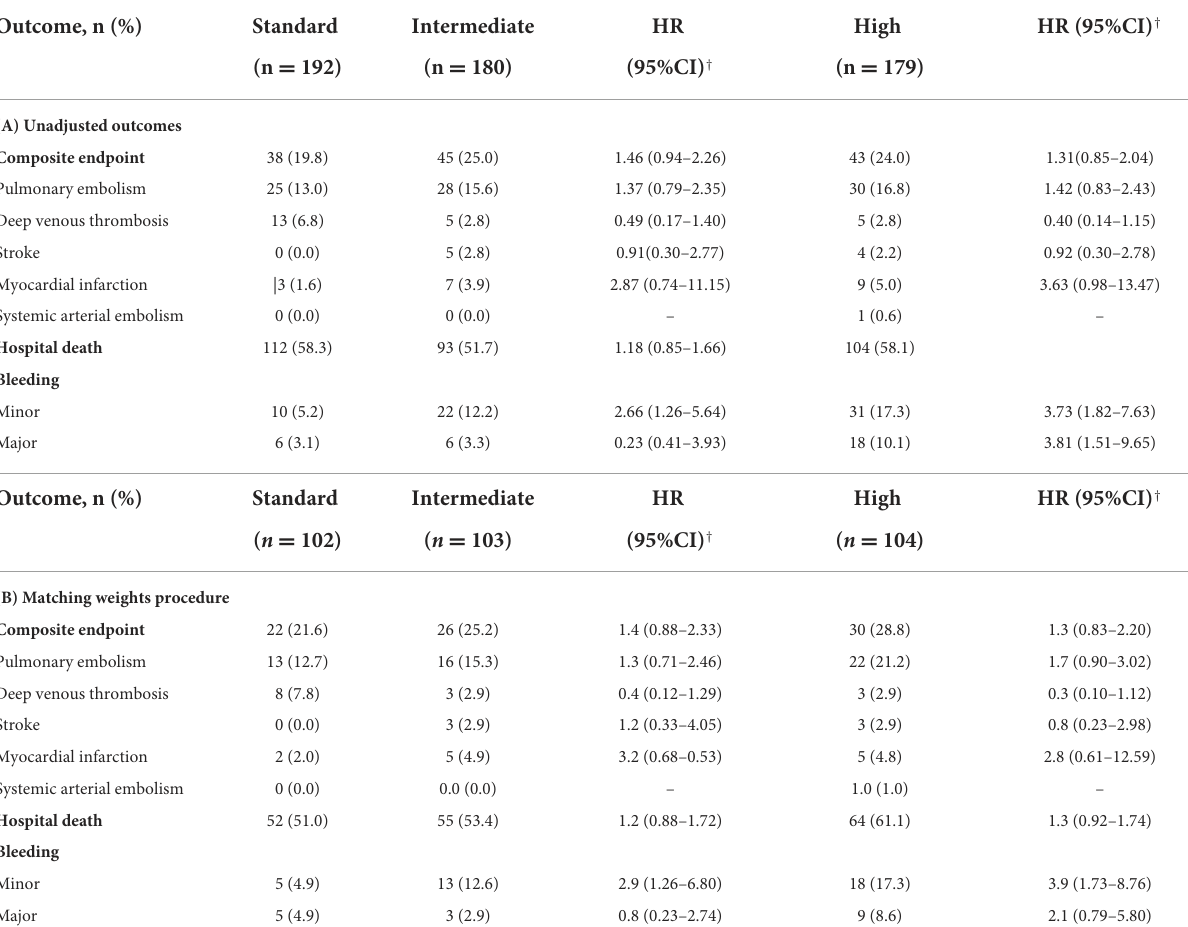
TABLE 3 Clinical outcomes